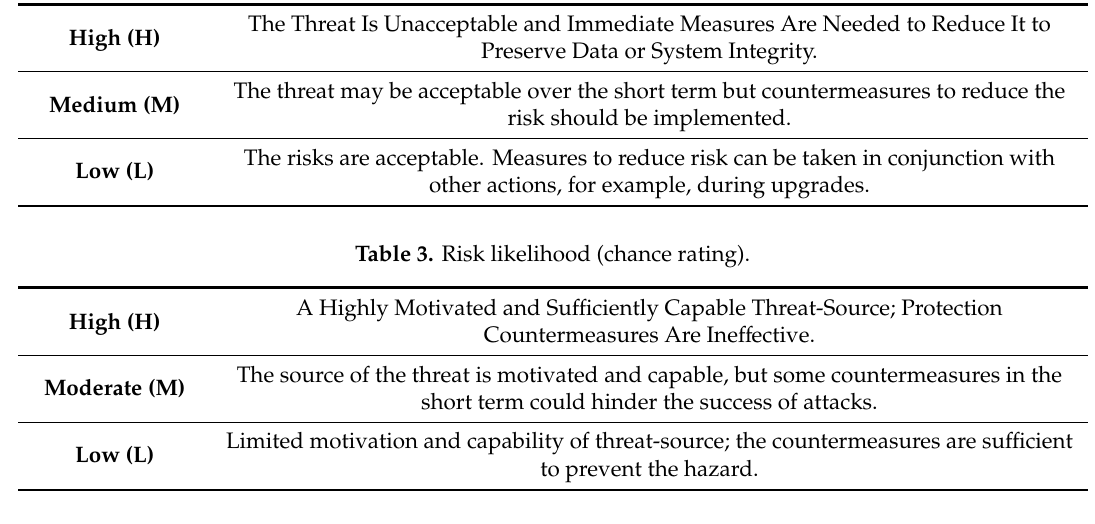
Table 2. Impact rating.